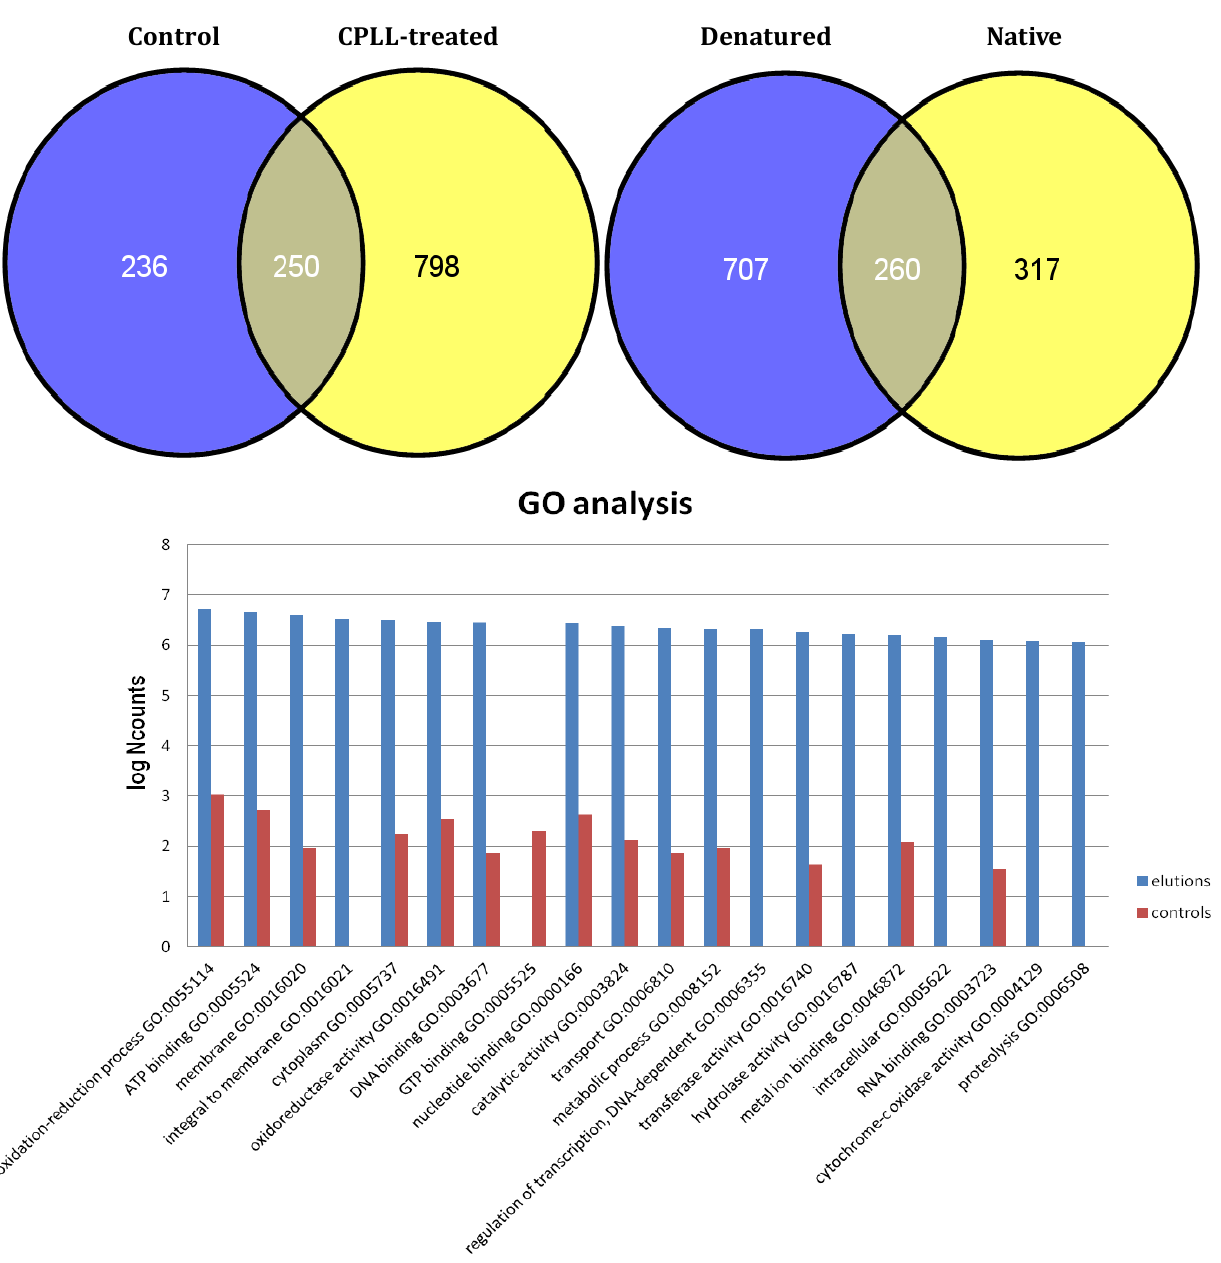
Figure 2. Upper panel: Venn diagrams showing the total identifications of avocado proteins in either the control or in the CPLL treated samples (left diagrams). The Venn diagrams to the right display the relative contributions to the total IDs of the denatured vs. the native sample extractions. Lower panel: GO analysis of the proteins detected in various metabolic processes in the control vs. CPLL-treated samples. In the latter case, five additional metabolic processes can be described, which are not visible in the control sample and most likely represent low- to very-low abundance proteins, whose visibility has been substantially enhanced via the CPLL technology (modified from Esteve et al.